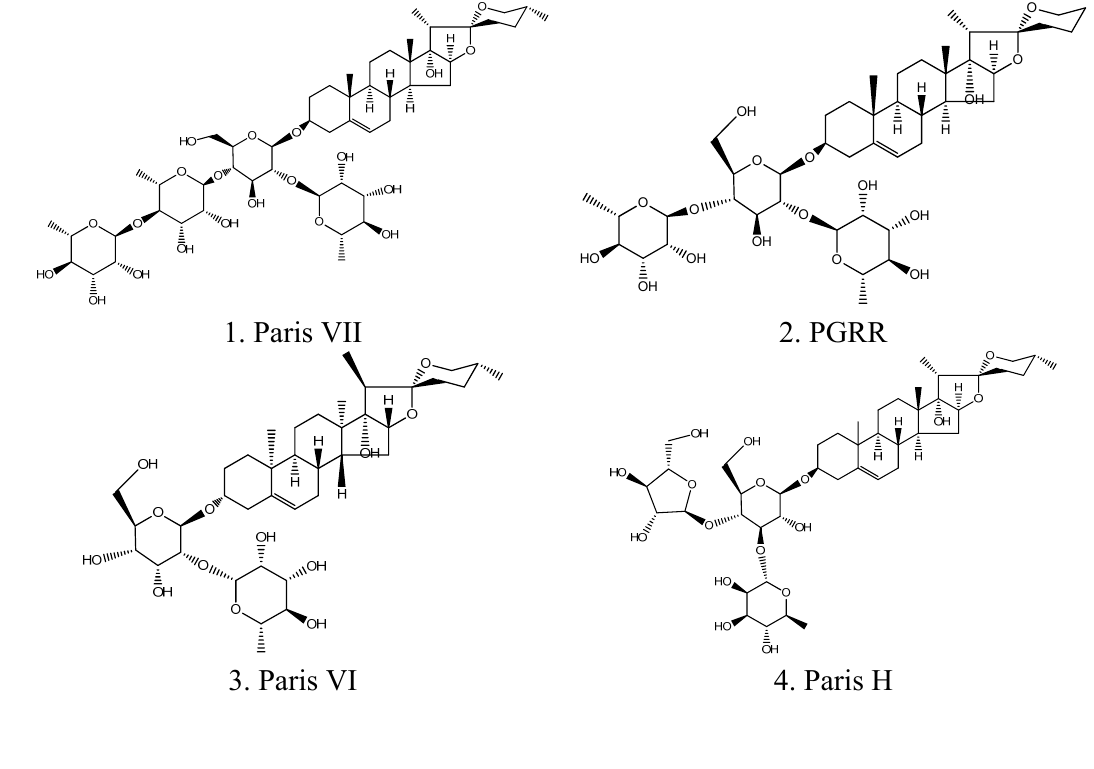
Figure 1. The chemical structure of nine steroidal saponins (PRS) including Paris